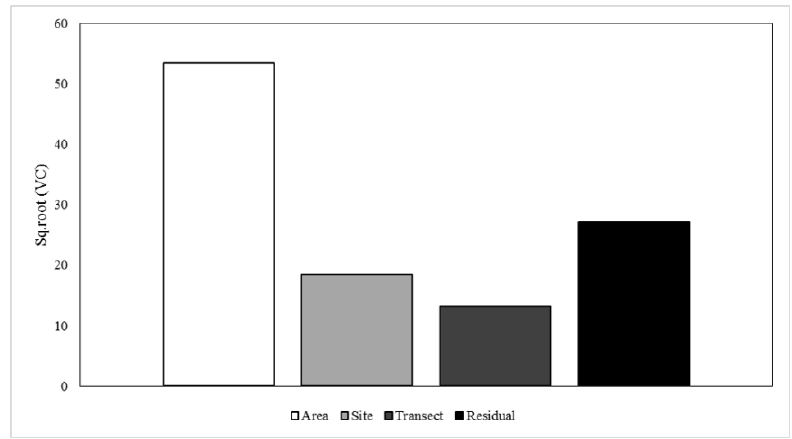
Figure 5. Square root of multivariate variance components (VC) at each spatial scale for all the algal species.